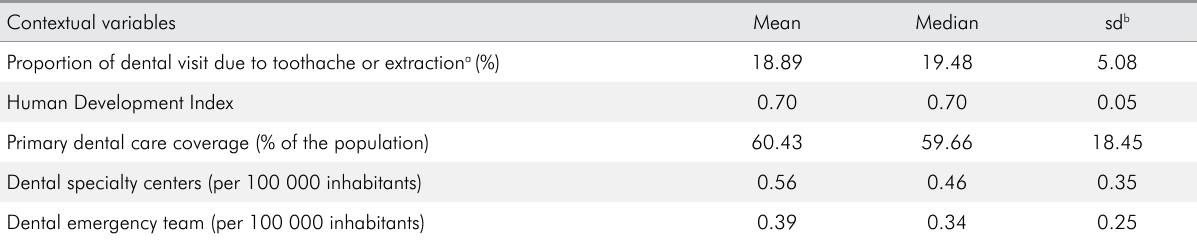
Table 4. Proportion of dental visits due to toothache or tooth extraction and description of exposure variables – results for Brazil, based on the data of the states. National Health Survey (PNS), 2019.